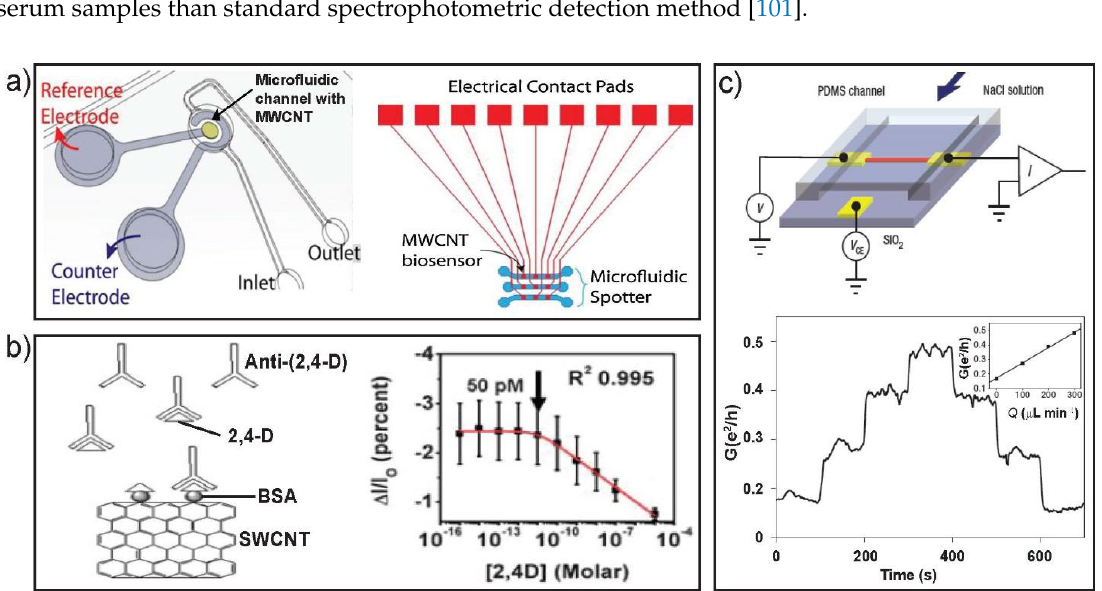
Figure 7. Microfluidic MWCNT-EC (electrochemical) detection system including ( a ) PDMS microfluidic channel with Pt counter and Ag/AgCl reference electrodes (left). The design of microfluidic biomolecule spotter with integrated MWCNT chip (right). ( b ) Schematic of direct assay detection of free 2,4-D (left) and response of the SWCNT-FET showing the response of the sensor toward BSA and anti-(2,4-D). ( c ) Experimental setup for the NT-based flow sensor on a PDMS microfluidic chip (top) and conductance-time signal for the flow sensor with flow rate stepped up sequentially through 0, 100, 200 and 300 μ L min −1 , and then back down sequentially through the same values (bottom). Images in ( a ) are reproduced with permission from [100], ( b ) from [102] and ( c ) from [103].